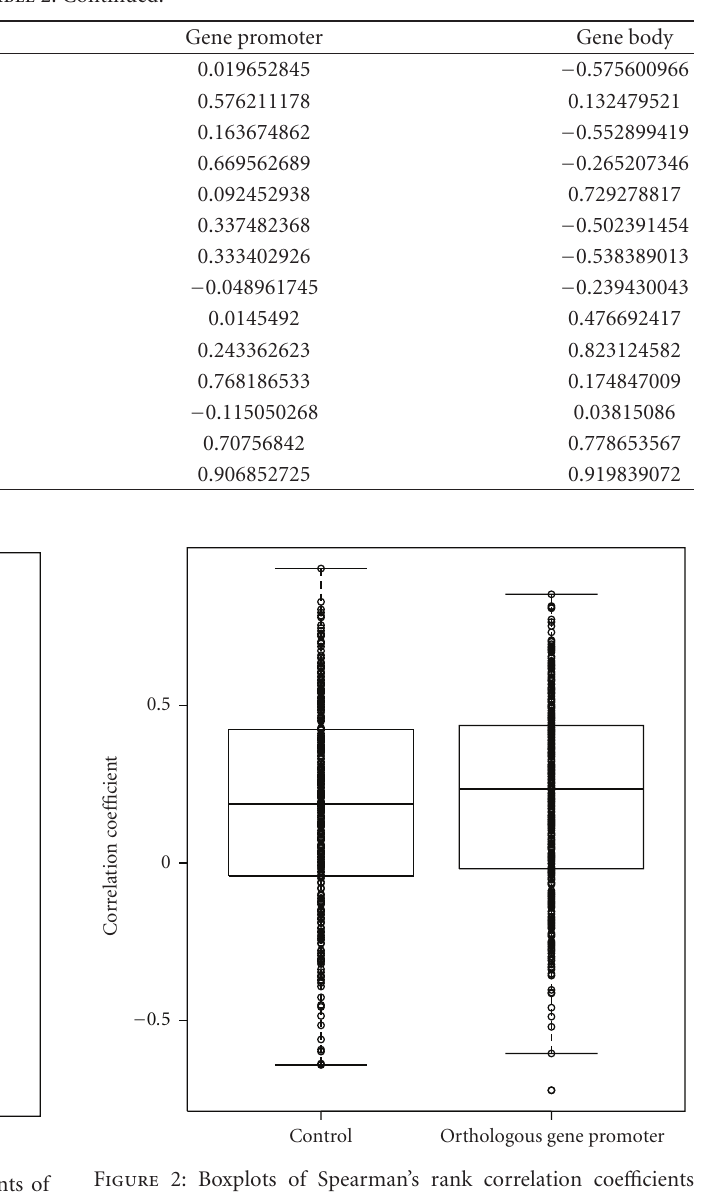
Figure 1: Boxplots of Spearman’s rank correlation coe ffi cients of nucleosome position profiles in the promoter and body regions of 63 duplicated gene pairs. Circles represent the correlation coe ffi cients and values of the same genes are connected by lines.